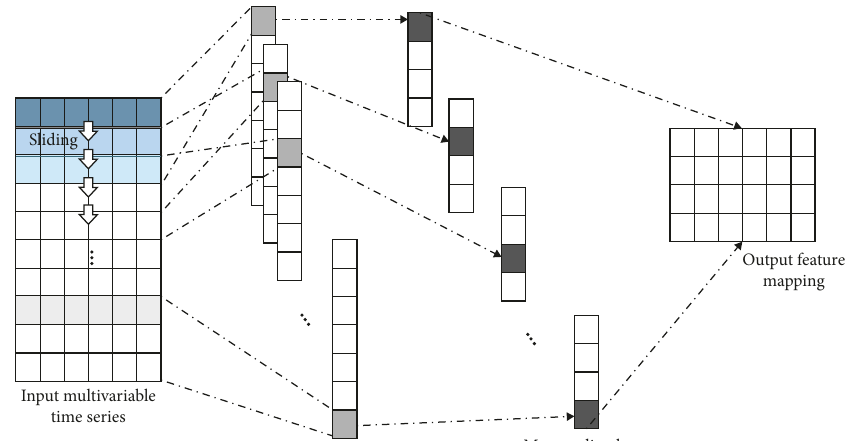
Figure 4: Temporal CNN module.